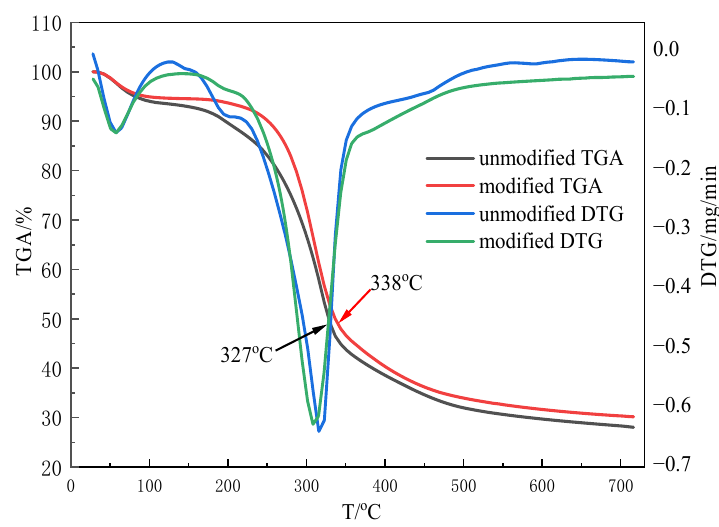
Figure 7. Thermograms of unmodi fi ed and modi fi ed.